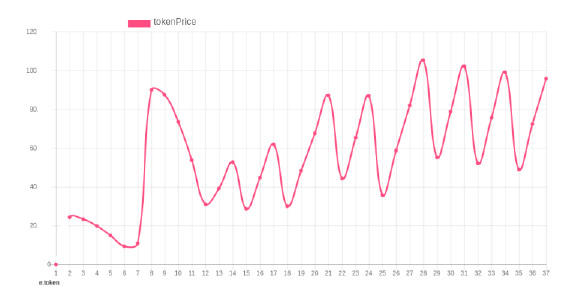
Figure 2. Token price